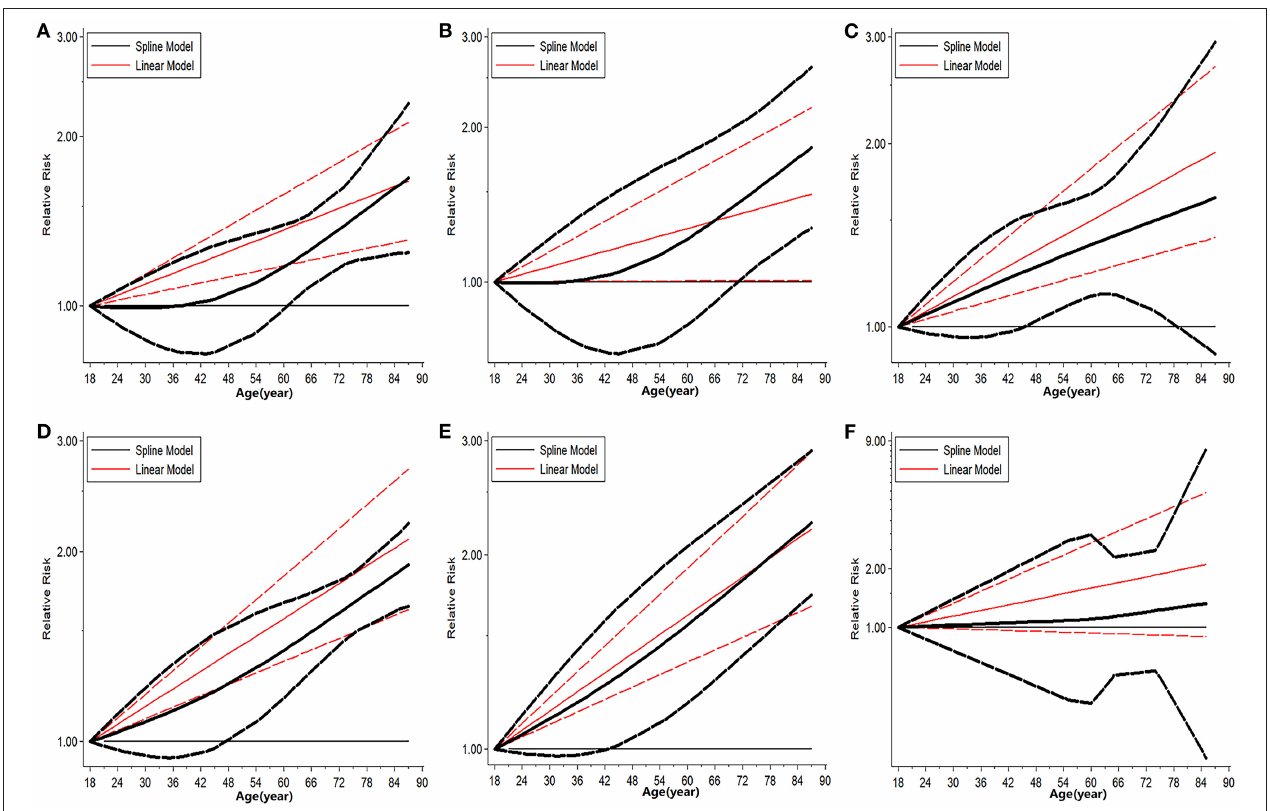
FIGURE 6 | Dose response analysis on risk of advanced donor age on GF. (A) Dose-response risk of advanced donor age on 90-day GF. (B) Dose-response risk of advanced donor age on 180-day GF. (C) Dose-response risk of advanced donor age on 1-year GF. (D) Dose-response risk of advanced donor age on 2-year GF. (E) Dose-response risk of advanced donor age on 3-year GF. (F) Dose-response risk of advanced donor age on 5-year GF. GF, graft